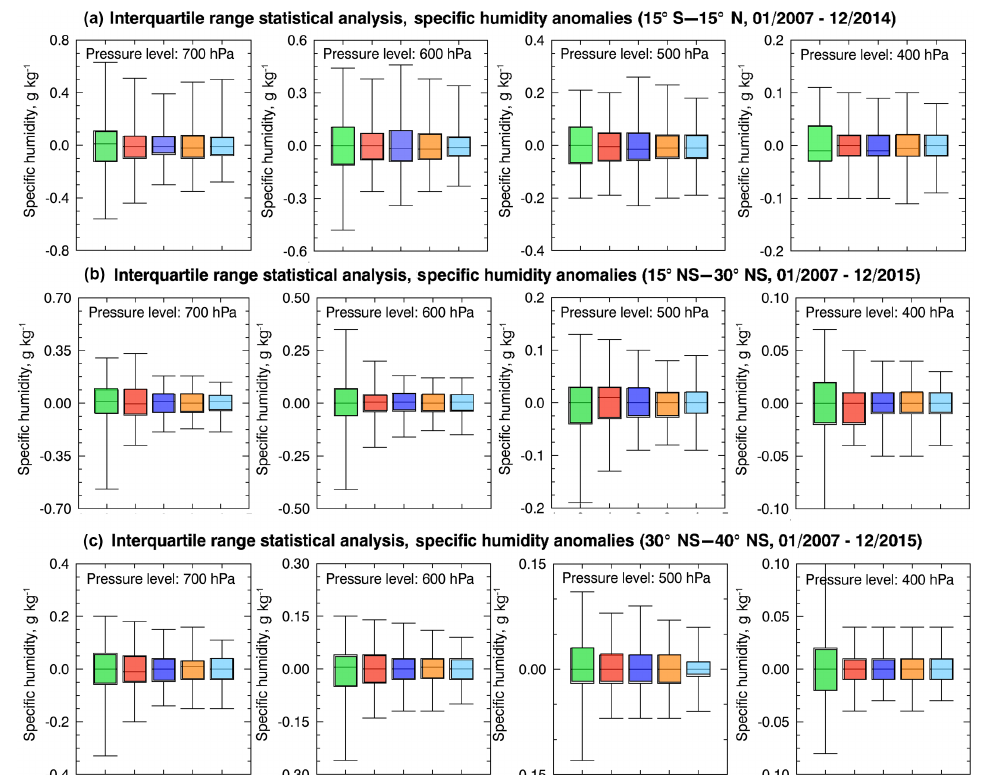
Figure 4. Same as Fig. 3 but for the specific humidity interannual